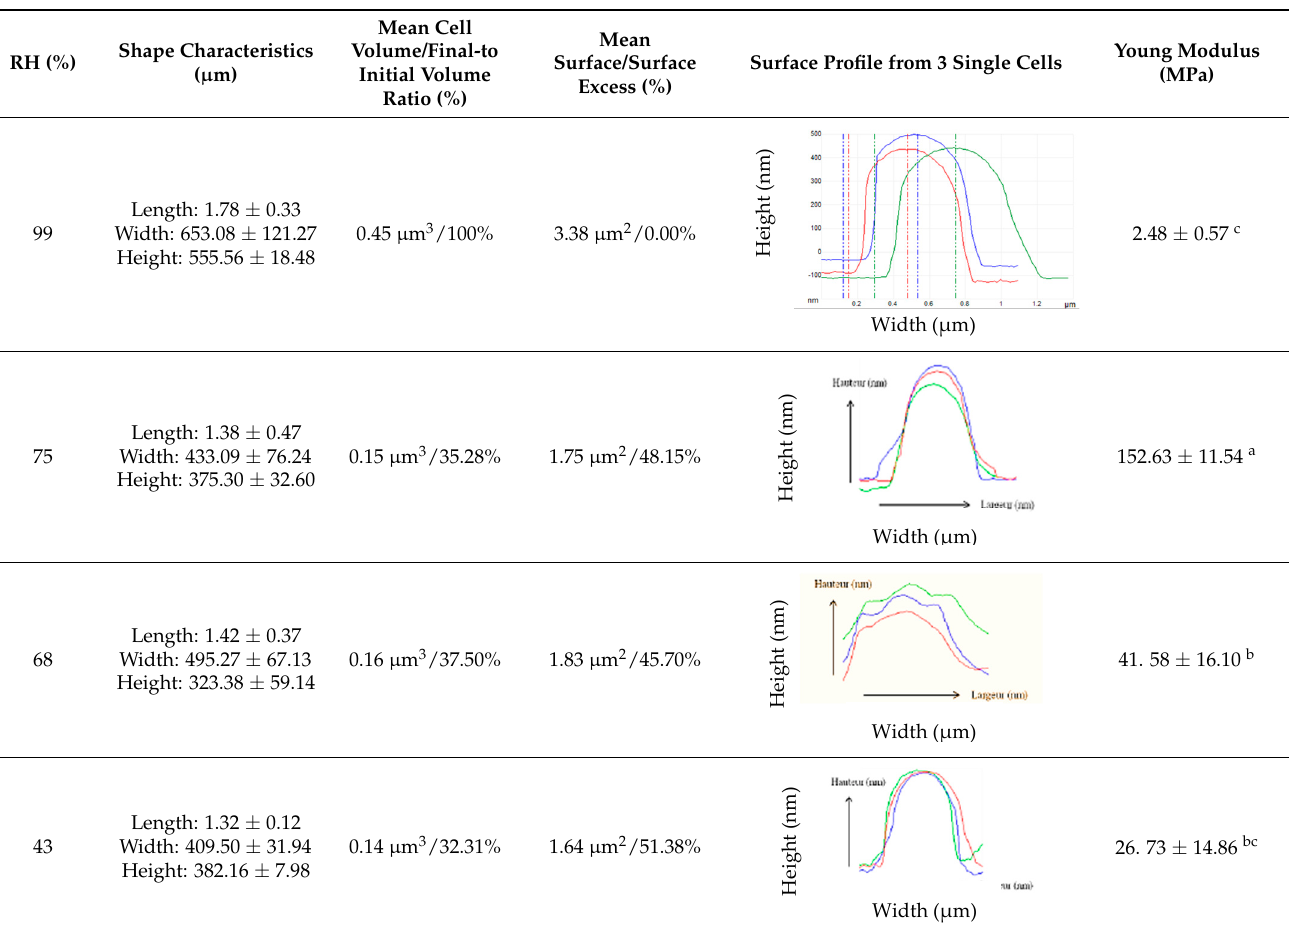
Figure 3. L. monocytogenes EGDe morphology observed by AFM height images after dehydration. Z-scale approx. 250 nm. Cells were ( A ) hydrated in PBS at 99% dehydrated or dehydrated in PBS at ( B ) 75%, ( C ) 68% or ( D ) 43% RH for 3 h at 25 °C. Cells were immobilized on a glass slide coated with poly- D -lysine. Table 1. L. monocytogenes EGDe morphology characteristics observed by AFM images in hydrated and dehydrated states as specified in Figure 3.